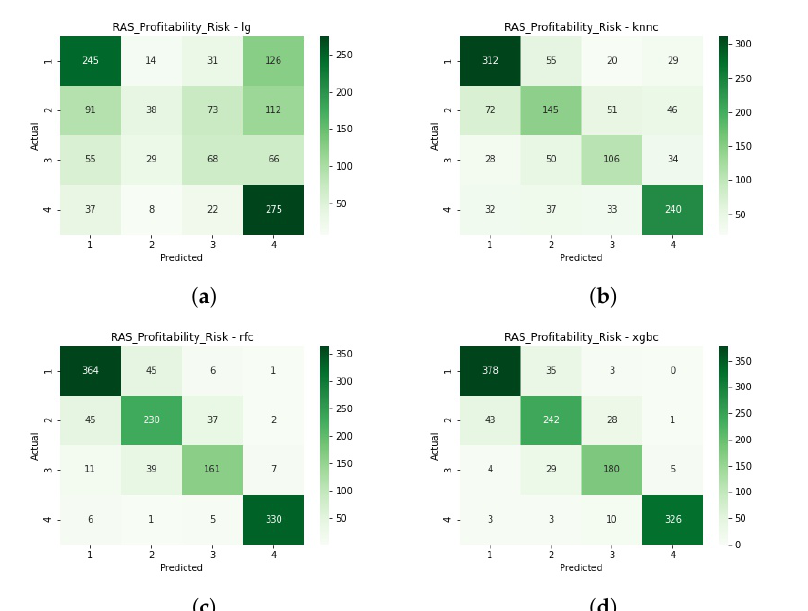
Figure A7. Profitability risk: confusion matrices generated when evaluating the above-mentioned models, using train-test split approach. ( a ) Logistic Regression. ( b ) k-Nearest Neighbours classifier. ( c ) Random Forest classifier. ( d ) Extreme Gradient Boosting classifier.